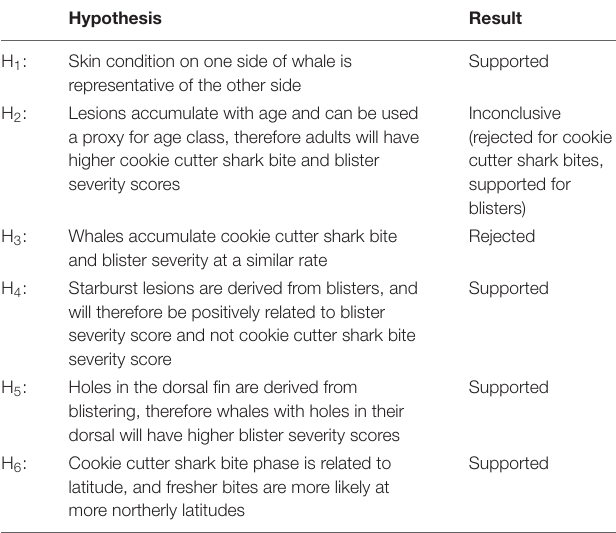
TABLE 3 | Hypotheses tested in this study, and the result for each.